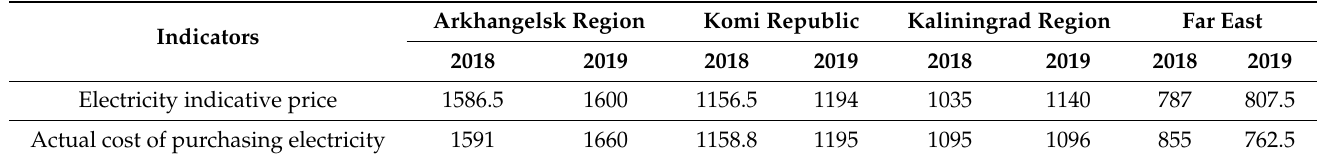
Table 4. Average price of electricity in the non-price zones of the wholesale electricity, rubles/MWh. Indicators Electricity indicative